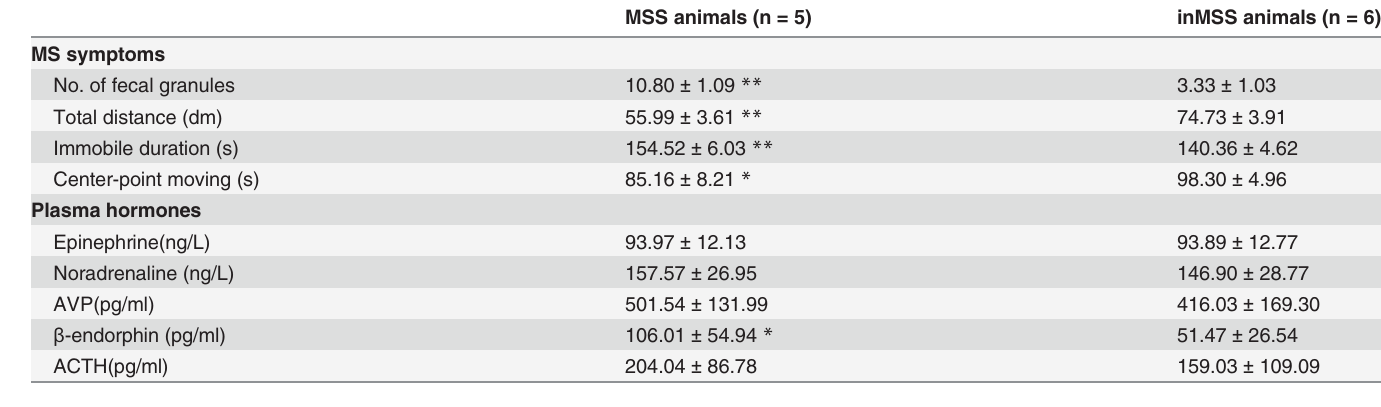
Table 2. MS symptoms and microarrayed plasma hormone levels of MSS-Rot and inMSS-Rot